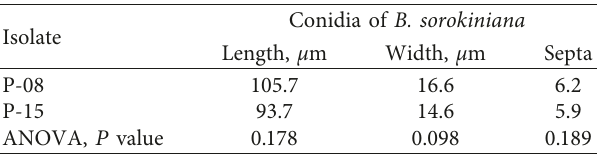
Table 1: Structural parameters of two isolates of B. sorokiniana on Czapek artificial cultural media barley seeds.